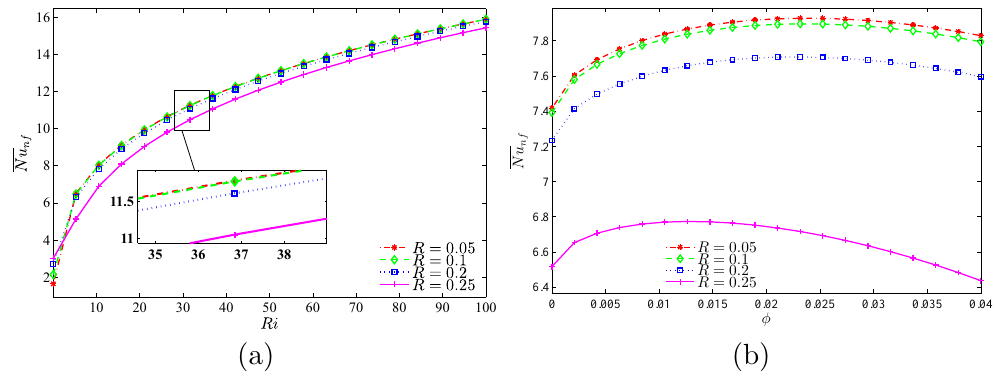
Figure 18. Variations of the average Nusselt number with ( a ) Ri and ( b ) φ for different R at Case 1 ( Ω ), N =